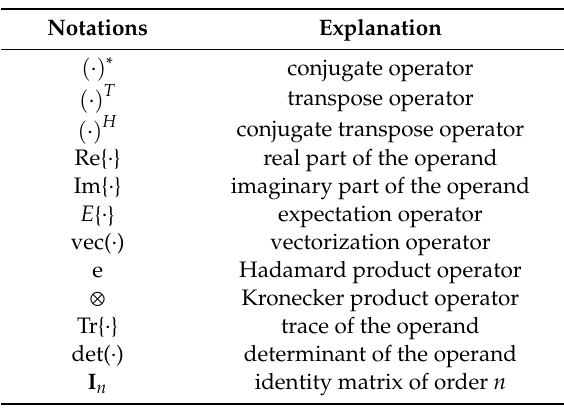
Table 1. List of